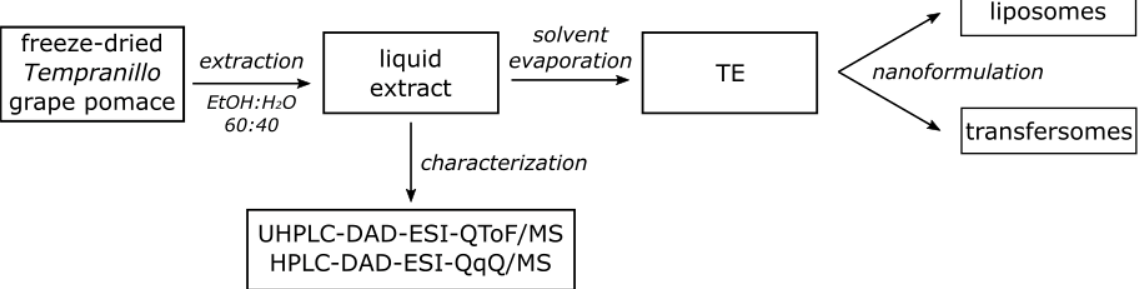
Figure 1. Scheme of extraction, characterization and nanoformulation of the extract.